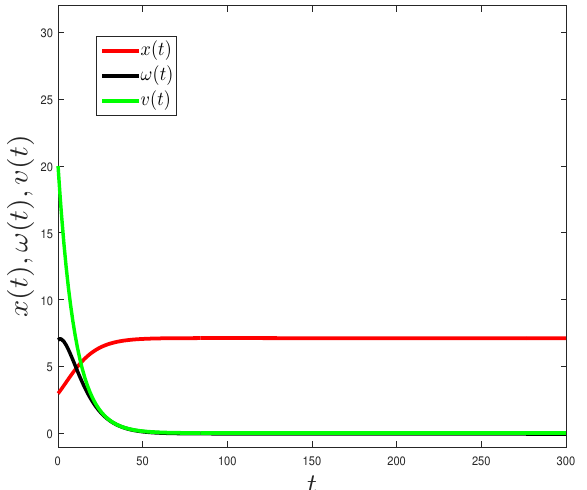
Figure 3. State dynamics for the system without irrigation, time t in days, where v ( t ) (green line), ω ( t ) (black line), and x ( t ) (red line) are the water available in the soil, the water inside the plant, and the amount of dry matter, respectively. Parameter values: x ( 0 ) = 3.0, ω ( 0 ) = 7.0, v ( 0 ) = 20.0, κ = 0.01, g = 0.1, m = 0.00001, δ = 1.0, r = 20, β = 0.1, k = 0.01, γ = 0.000009, ρ =